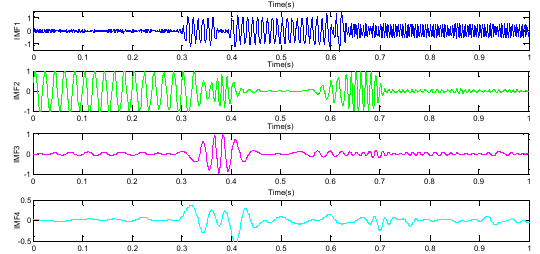
Figure 2. IMF components obtained by decomposing synthetic data with EMD.